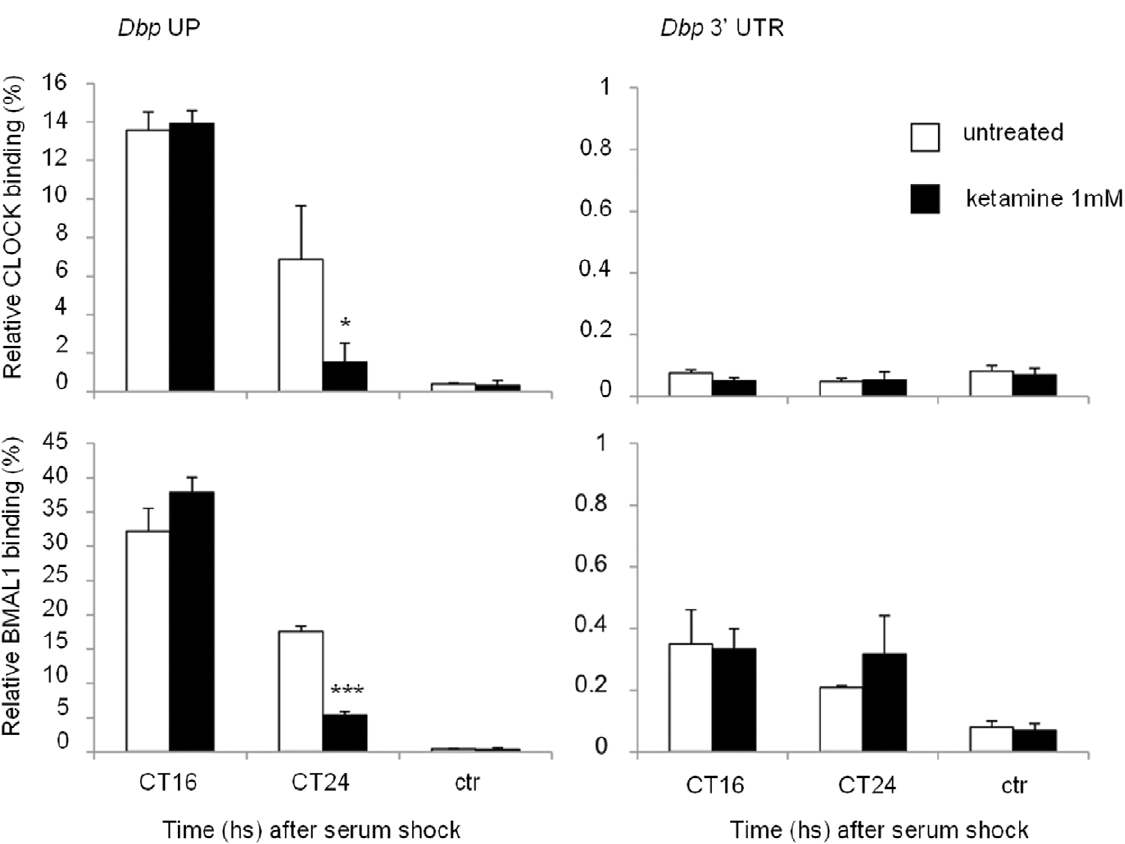
Figure 3. Altered CLOCK and BMAL1 circadian recruitment to CCGs promoter after ketamine treatment. Cross-linked cell extracts were isolated at the indicated time points after serum shock from MEFs, not treated or treated with ketamine (1 mM) for 1 h before each time point. The samples were subjected to ChIP assay with anti-CLOCK, anti-BMAL1 and anti-IgG, and analyzed by quantitative PCR with primers for Dbp promoter. Control IgG (ctr) and Dbp 3 9 UTR (3 9 region of Dbp promoter) primers were used as controls for immunoprecipitation and PCR, respectively. All the values are the mean + / 2 SD (n=3); (*) p , 0.05, (***) p , 0.001.